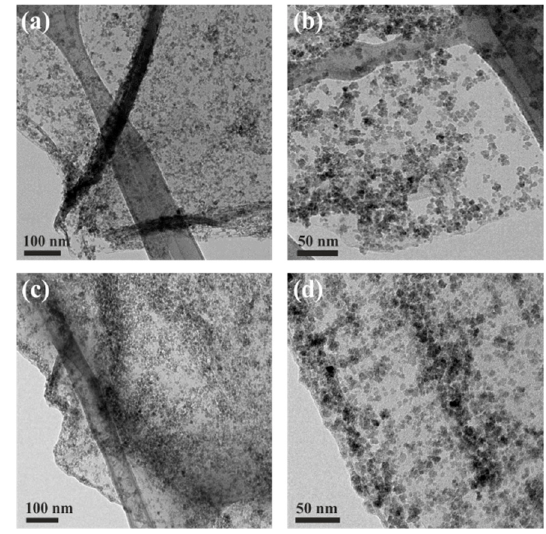
Figure 6. TEM images of SPION-RGO hybrids ( a , b ) before and ( c , d ) after being exposed to human serum at 37 °C for 24 h.